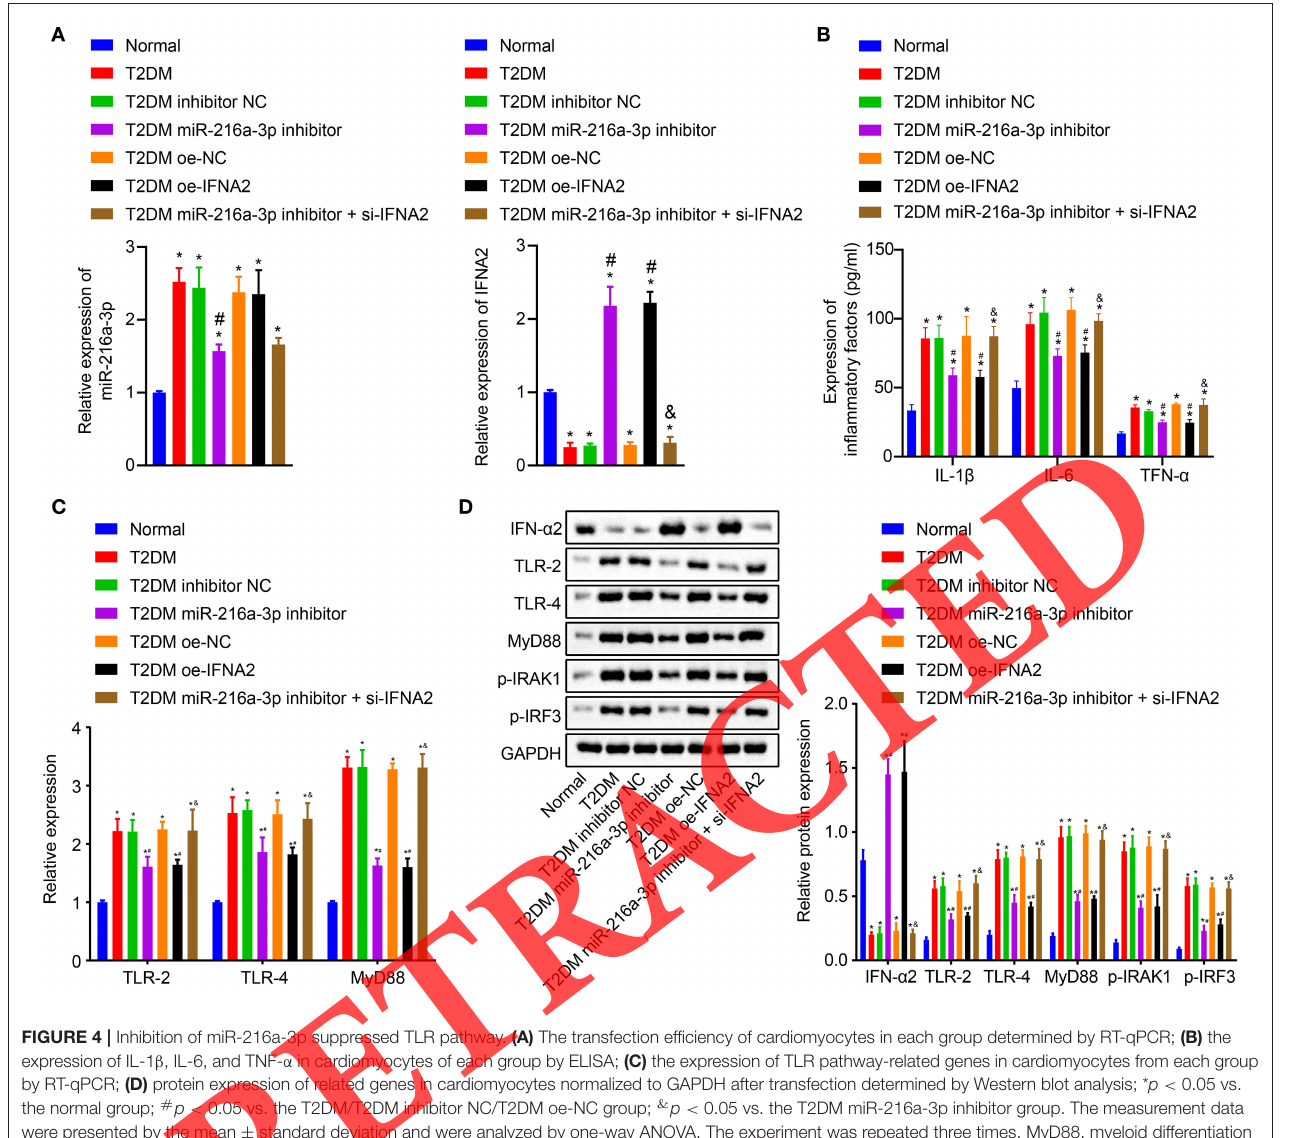
FIGURE 4 | Inhibition of miR-216a-3p suppressed TLR pathway. (A) The transfection efficiency of cardiomyocytes in each group determined by RT-qPCR; (B) the expression of IL-1 β , IL-6, and TNF- α in cardiomyocytes of each group by ELISA; (C) the expression of TLR pathway-related genes in cardiomyocytes from each group by RT-qPCR; (D) protein expression of related genes in cardiomyocytes normalized to GAPDH after transfection determined by Western blot analysis; * p < 0.05 vs. the normal group; # p < 0.05 vs. the T2DM/T2DM inhibitor NC/T2DM oe-NC group; & p < 0.05 vs. the T2DM miR-216a-3p inhibitor group. The measurement data were presented by the mean ± standard deviation and were analyzed by one-way ANOVA. The experiment was repeated three times. MyD88, myeloid differentiation factor 88; p-IRAK1, phosphorylation of interleukin-1 receptor-associated kinase 1; p-IRF3, phosphorylation of interferon regulatory factor 3; GAPDH, glyceraldehyde-3-phosphate